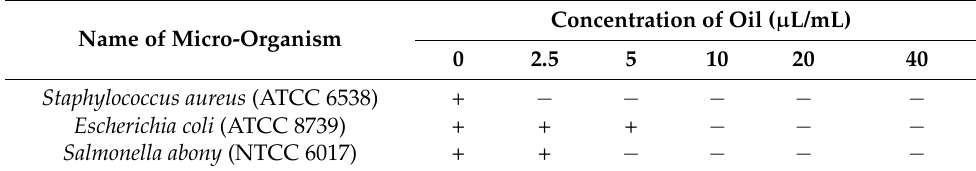
Table 2. Inhibitory effects of the Artemisia ordosica essential oil on the three microbial strains. Name of